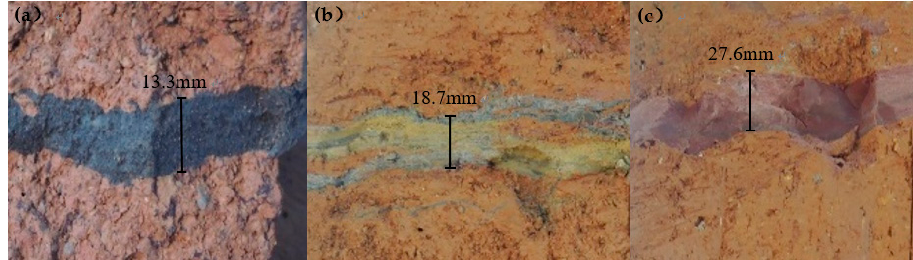
Figure 6. Framework grouting vein: ( a ) original grouting vein, ( b ) yellow grouting vein, and ( c ) red grouting vein.